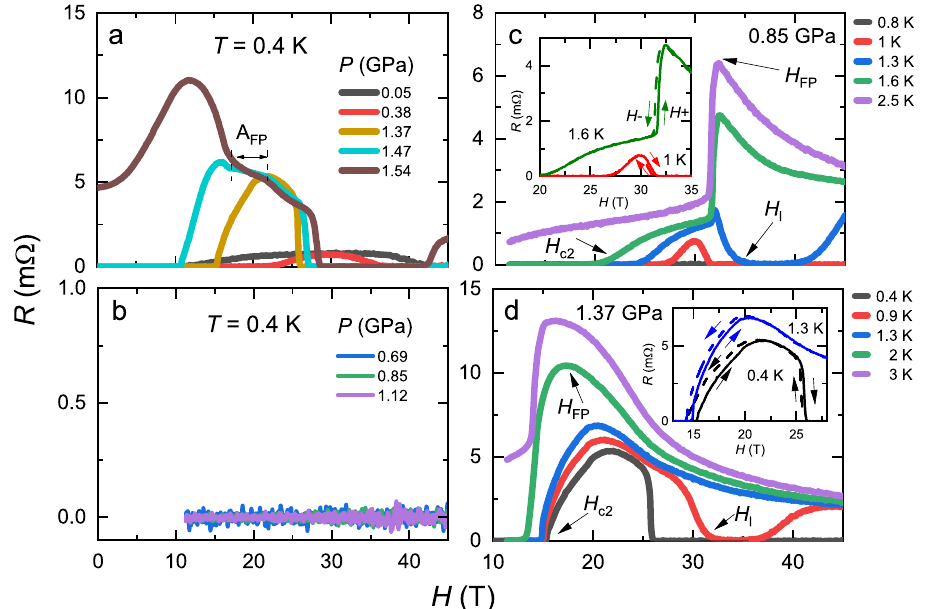
Fig. 3 High- fi eld magnetoresistance, showing phase boundaries at different pressures. Magnetic fi eld is applied at 25° from b axis toward c axis. a Pressure dependence of 0.4 K magnetoresistance, showing the sharpening of phase boundaries at higher pressures and emergence of high-pressure phase A FP . b The resistance at pressures 0.69, 0.85, and 1.12 GPa is zero between 11 and 45 T at 0.4 K. Zero resistance persists to zero magnetic fi eld at these pressure values. c For fi elds lower than H FP , the superconducting transitions H C2 are broad, but H FP is sharp. As shown in inset, H FP is hysteretic, re fl ecting the 1st order transition, both at high temperatures in the FP phase and low temperature in the SC FP phase. d Much sharper superconducting phase boundaries occur once H FP limits SC FP . As shown in inset, low- fi eld phase boundaries are hysteretic and fi rst order, as is the onset of SC FP .